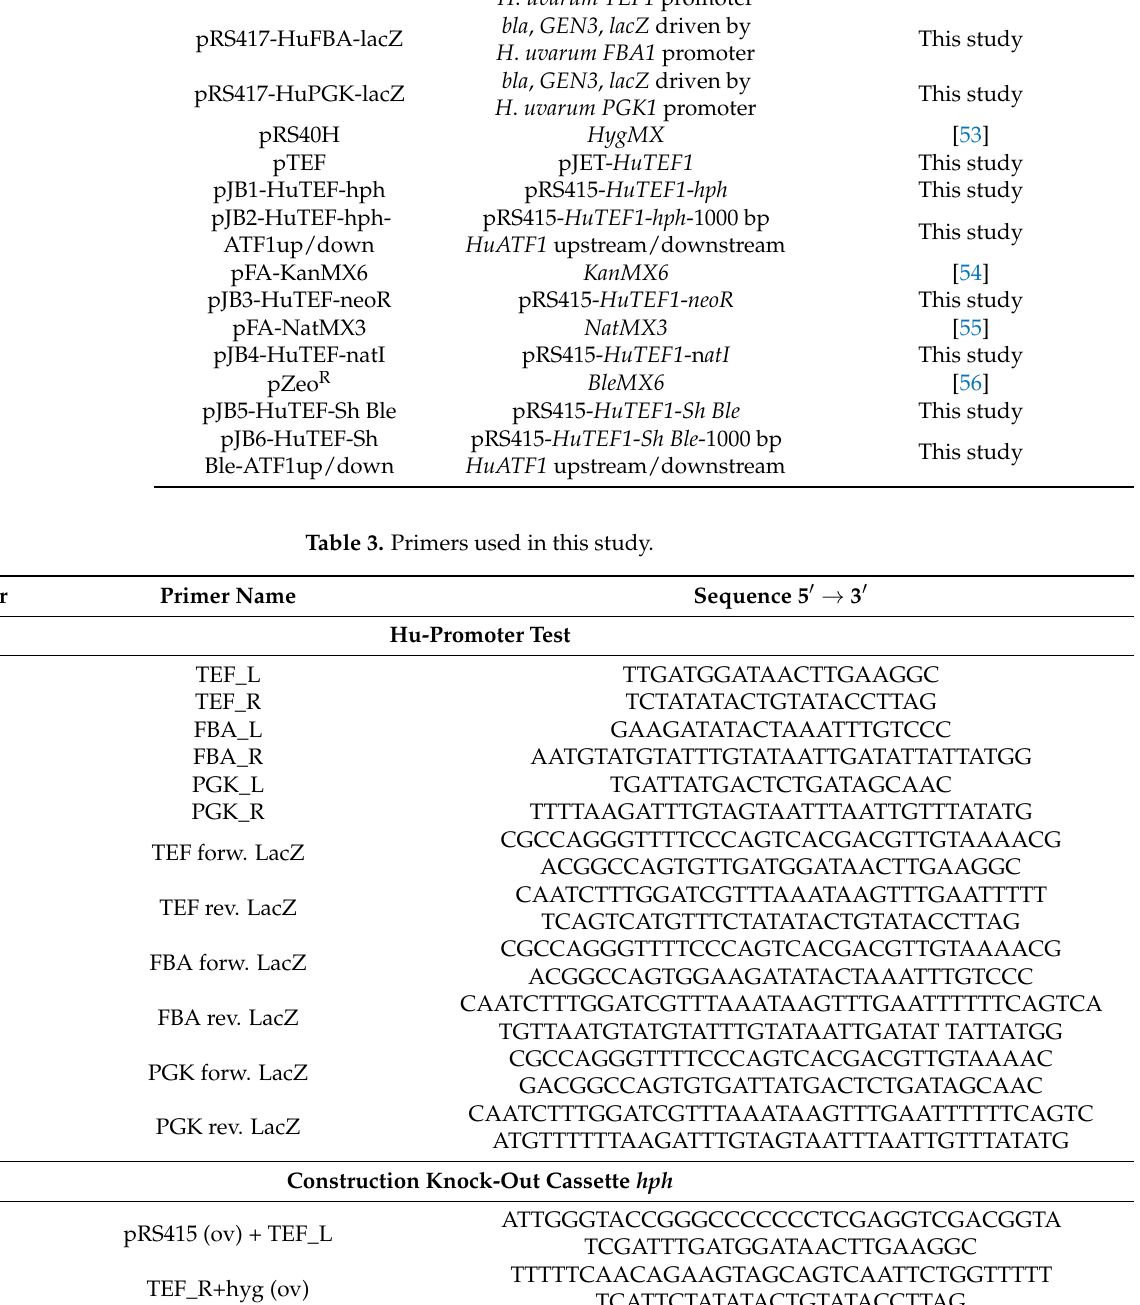
Table 2. Plasmids used and generated in this study.